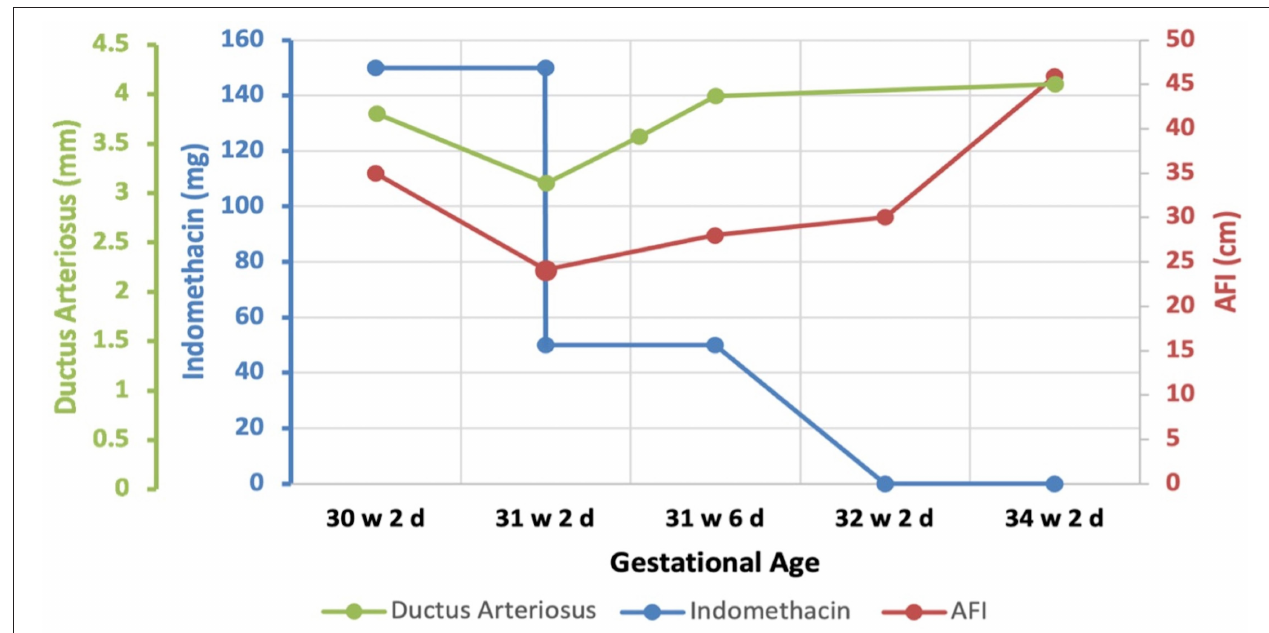
FIGURE 5 | A summary diagram to outline changes in AFI and DA diameter during the antenatal indomethacin therapy of the patient.